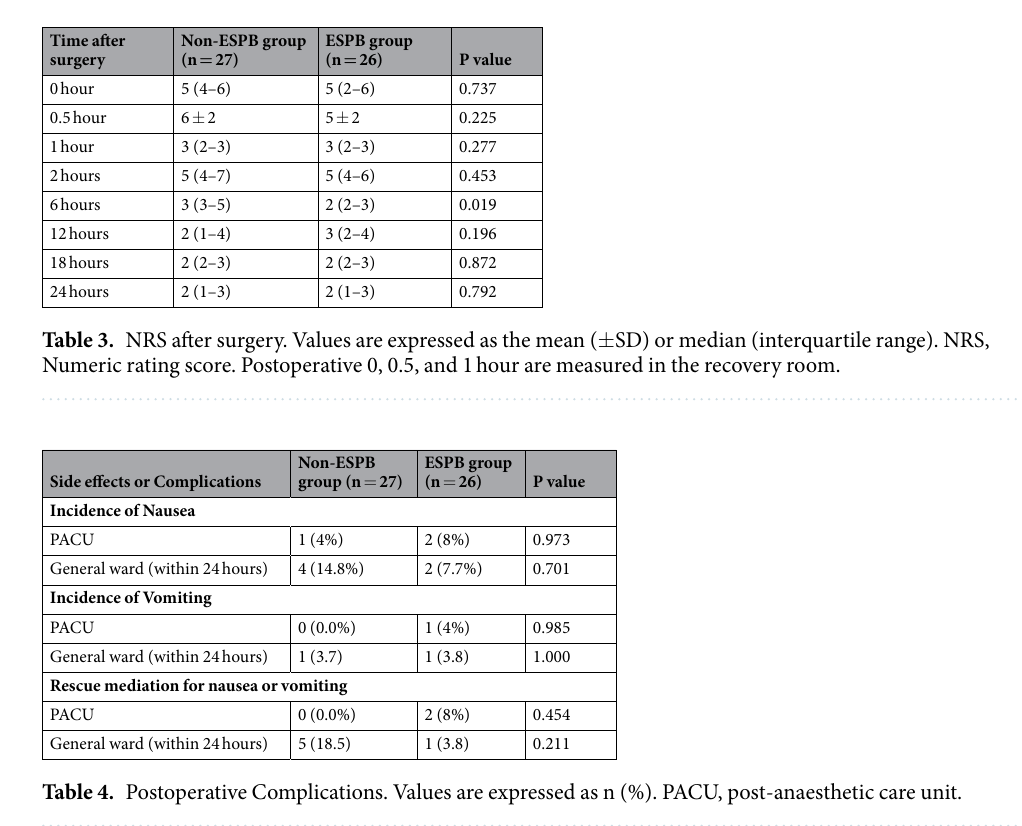
Figure 2. Cumulated analgesic consumption. All analgesics were converted to equivalent fentanyl dose ( μ g) and were divided by patient’s weight (kg). Cumulated fentanyl consumption at 24-hour is the primary outcome. Data are expressed as the median and interquartile range. ∗ P < 0.05 indicates statistical significance. ESPB, erector spinae plane block; PACU, postanaesthetic care unit.